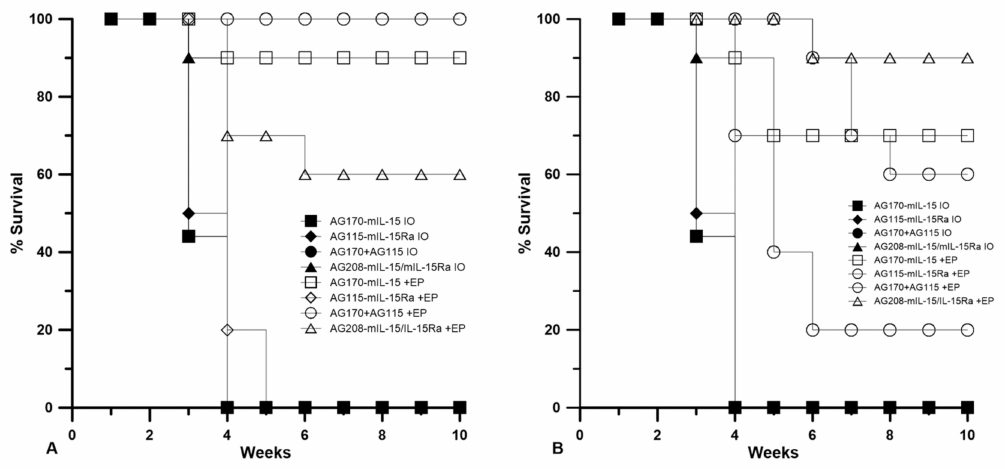
Figure 3. IL-15 GET induces the long-term survival of mice. The survival of mice monitored above is represented as the percent survival of the experimental group over time. Electrotransfer protocols were used as indicated. ( A ) EP1 = 1300 V / cm, 100 us, 6 pulses of EP1 delivered using a 6 penetrating needle array. ( B ) EP2 = 600 V / cm, 5 ms, 10 pulses of EP2 delivered using caliper electrodes. n = 10 for each group. IO = injection only; EP =